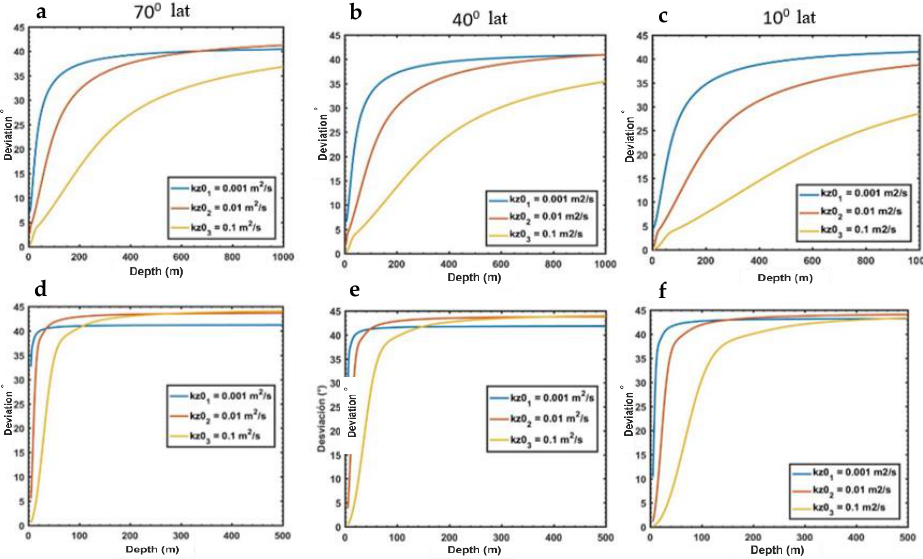
Figure 6. Ekman surface current deviation — ( a – c ) correspond to a highly stratified profile. Graphs ( d – f ) belong to a slightly stratified profile. The k z values considered are indicated in the corresponding legend. The left, center, and right column graphs are for 70°, 40°, and 10°, respectively.